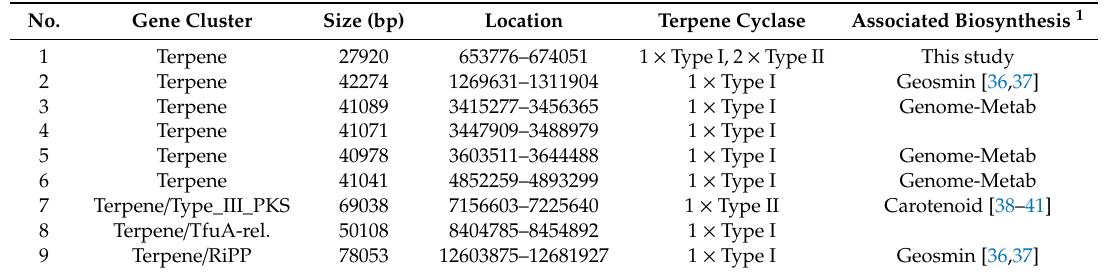
Table 3. Biosynthetic gene clusters identified through antiSMASH analysis harboring a terpene cyclase. No. Gene